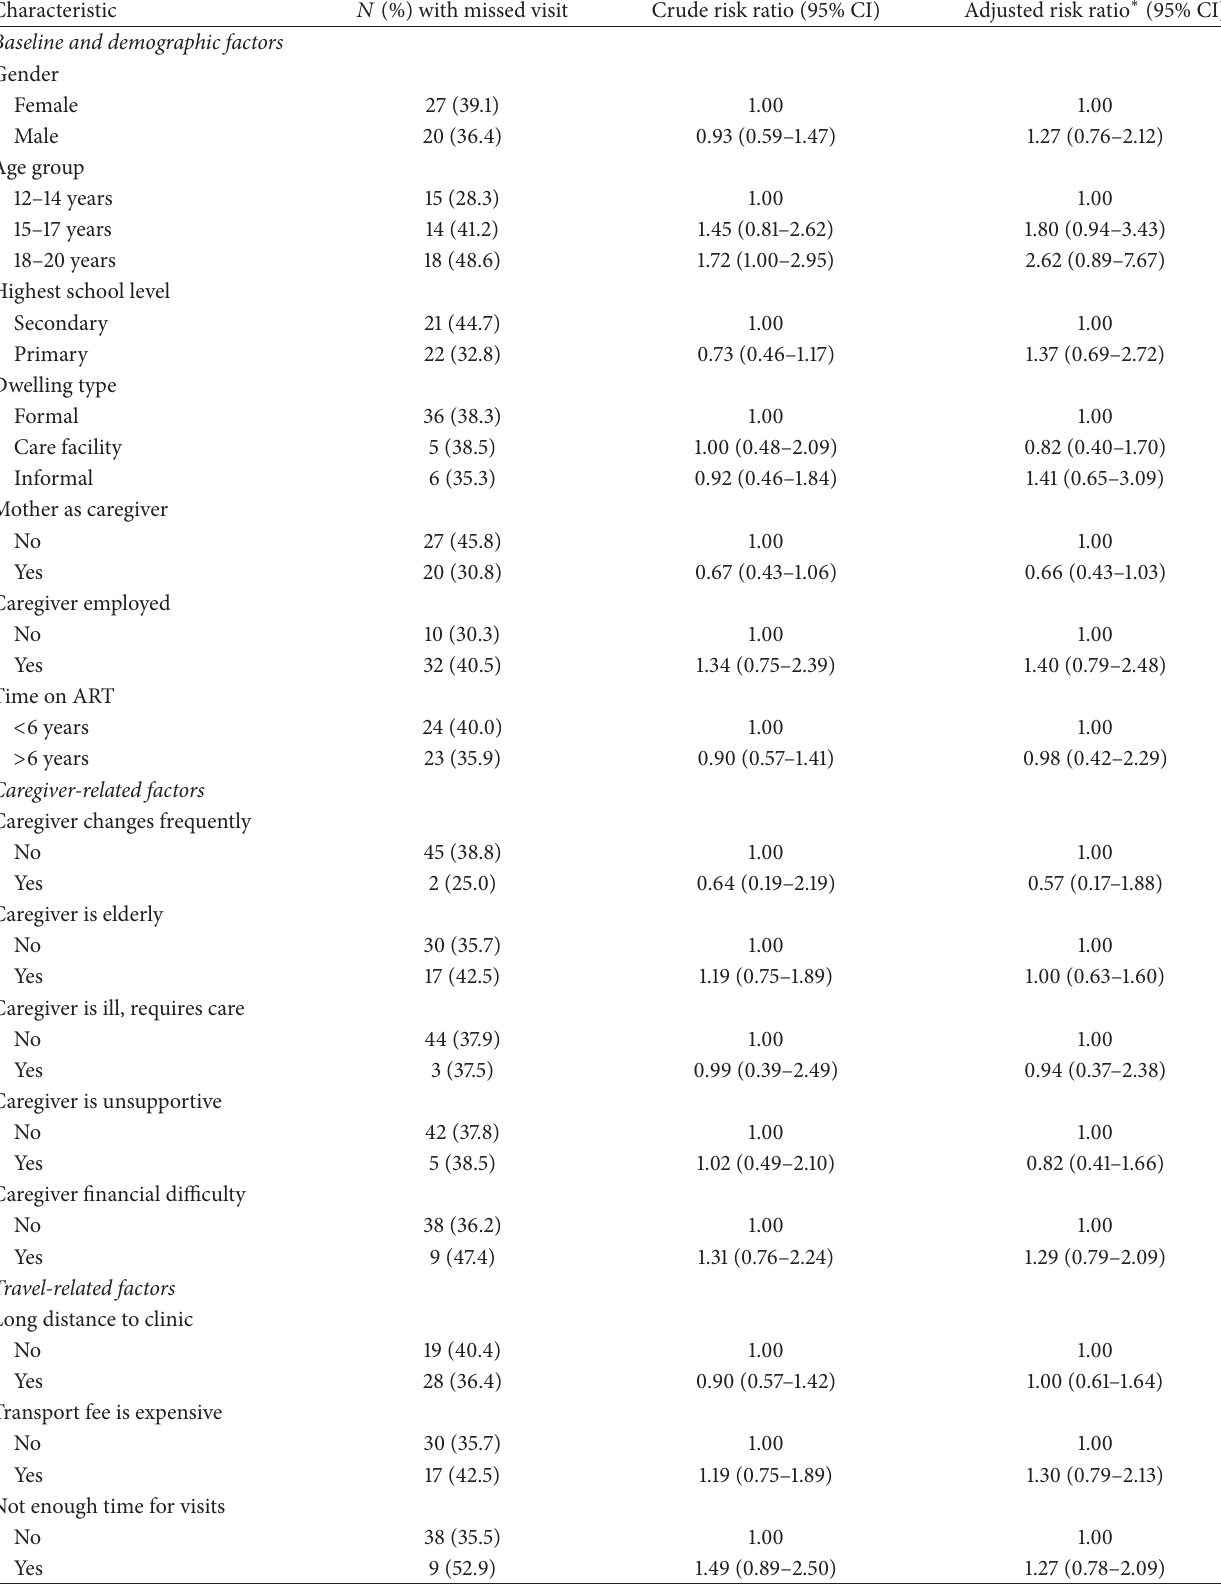
Table 3: Factors associated with having at least one late or missed visit (𝑛 = 124)